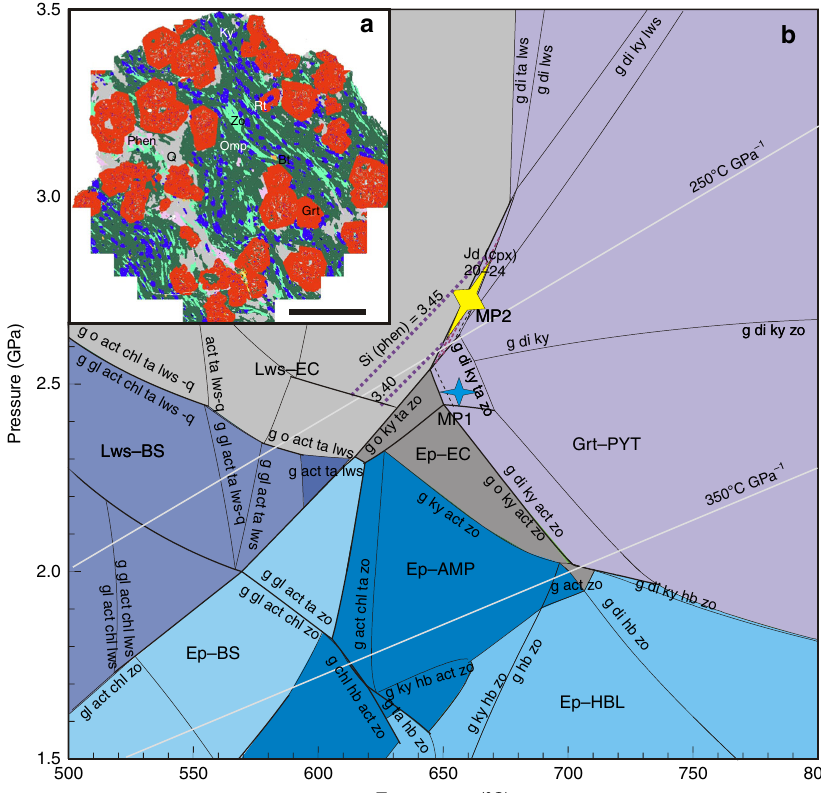
Fig. 2 Mineral mapping of the fresh eclogite xenolith and P – T phase diagram. a The eclogite contains typical minerals of garnet (Grt) and omphacite (Omp), which do not show any retrogressed feature. The coarse-grained garnets are rimmed by quartz (Q) and phengite (Phen), indicating a relatively high pressure and low temperature metamorphism. Ky kyanite, Zo zoisite, Bt biotite, Rt rutile. The scale bar is 5 mm. b P – T diagram is calculated in the NCKFMASH system 27 according to the effective bulk-rock composition obtained from a . The peak pressure and temperature (labeled as MP1) are calculated using the Zr-in-rutile and mineral-pair thermobarometer (Supplementary Table 7). The peak metamorphic pressure and temperature, labeled as MP2, are independently constrained by the jadeite and Si contents of omphacite and phengite (purple dash line), respectively. The standard deviation (±1.4 kbar) in pressure is adopted on the basis of a Monte Carlo assessment on the phase equilibrium modeling 53 . Combining MP1 and MP2 data gives a thermal gradient of 250(±15)°C GPa − 1 . Lws lawsonite, Ep epidote, Grt garnet, Jd jadeite, CPX clinopyroxene, Phen phengite, EC eclogite, PYT pyroxenite,